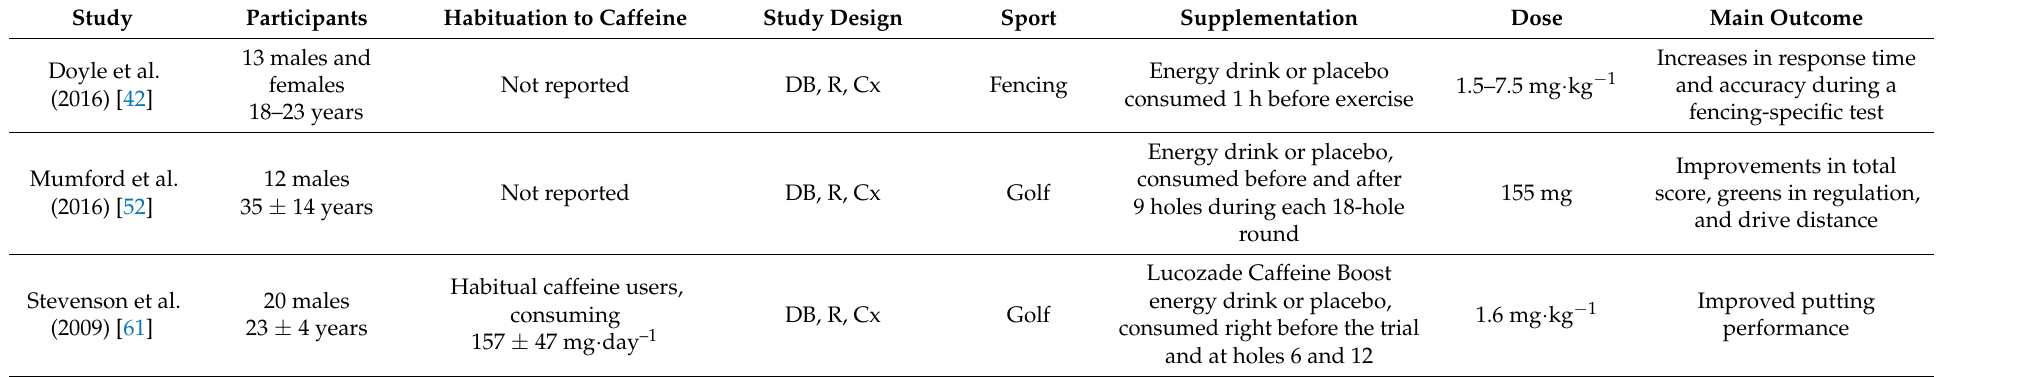
Table A5. Investigations in skill-based sports.